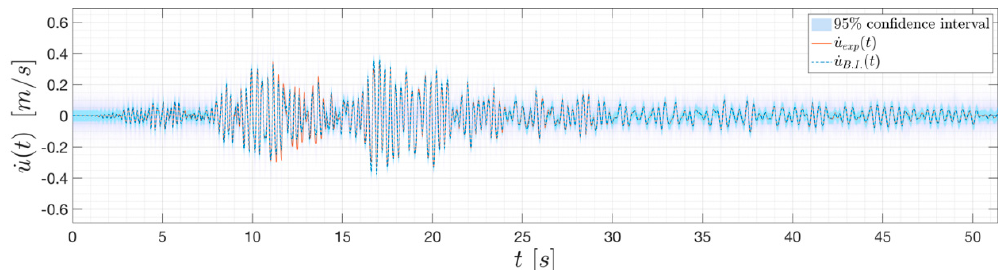
Figure 15. Velocity response prediction of the BWBN Model 3 for high level of degradation (PGA of 9 m/s 2 , stiffness reduction up to 80% of the initial one).